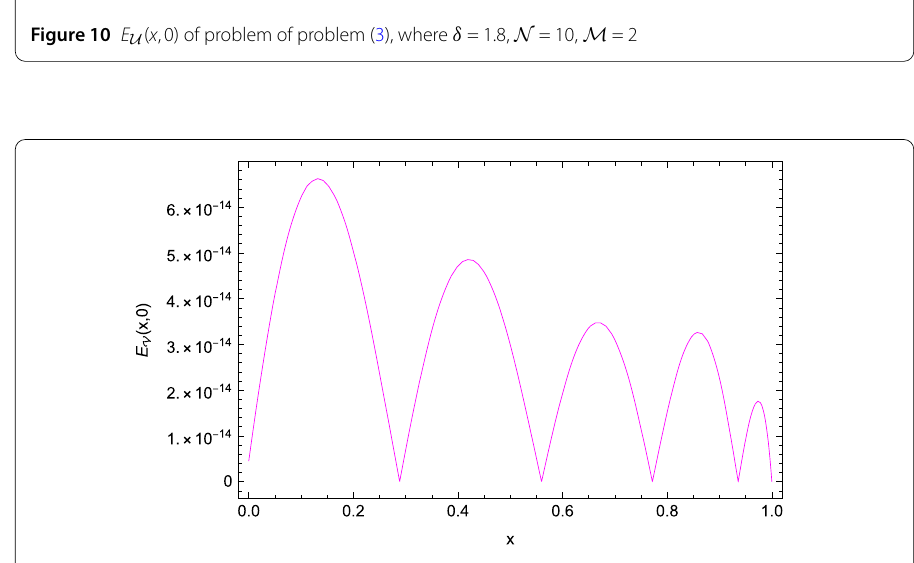
Figure 11 E V ( x ,0) of problem (3), where δ = 1.8, N = 10, M =